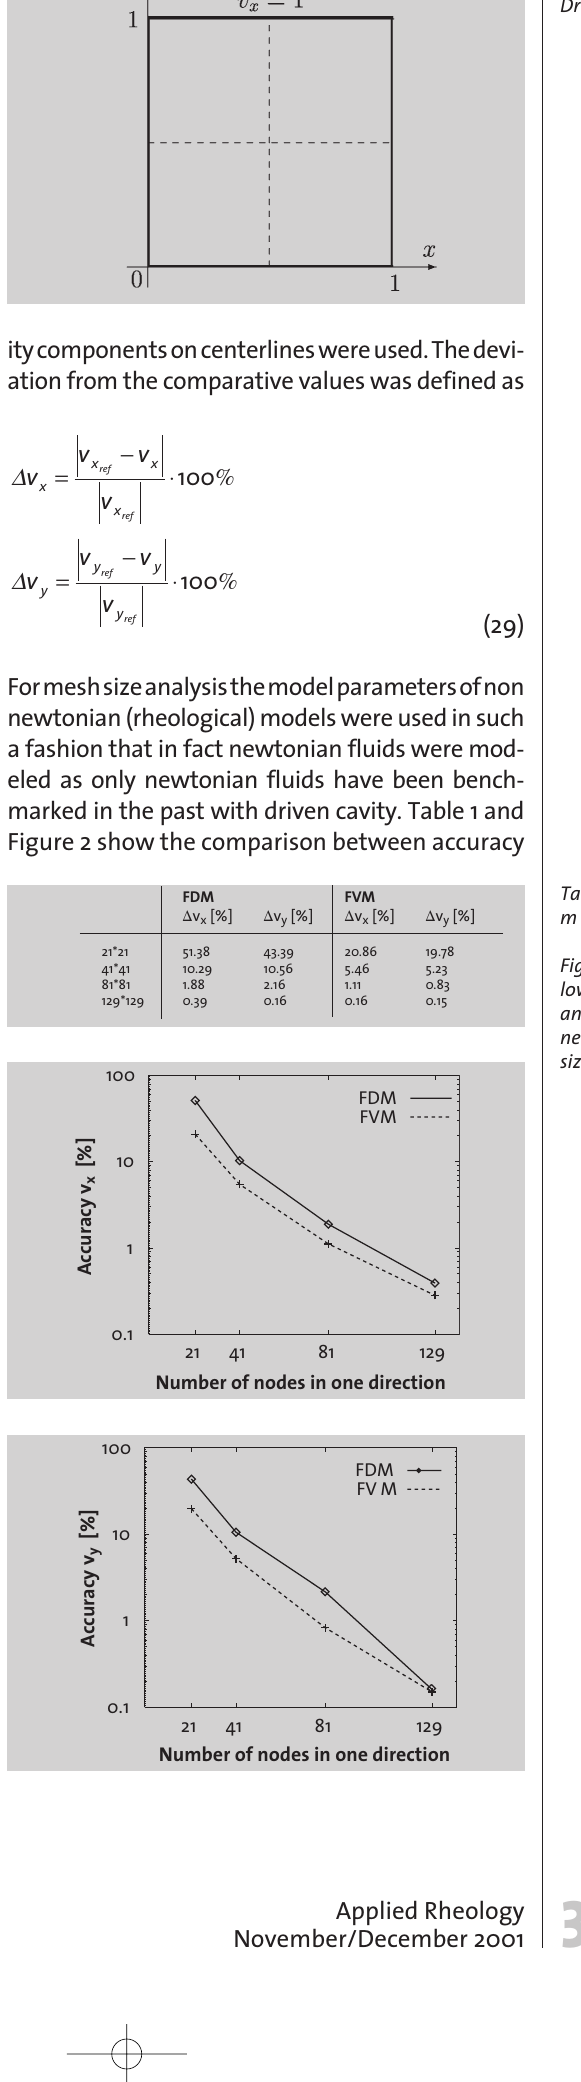
Figure 1: Geometry and boundary conditions: Driven cavity.